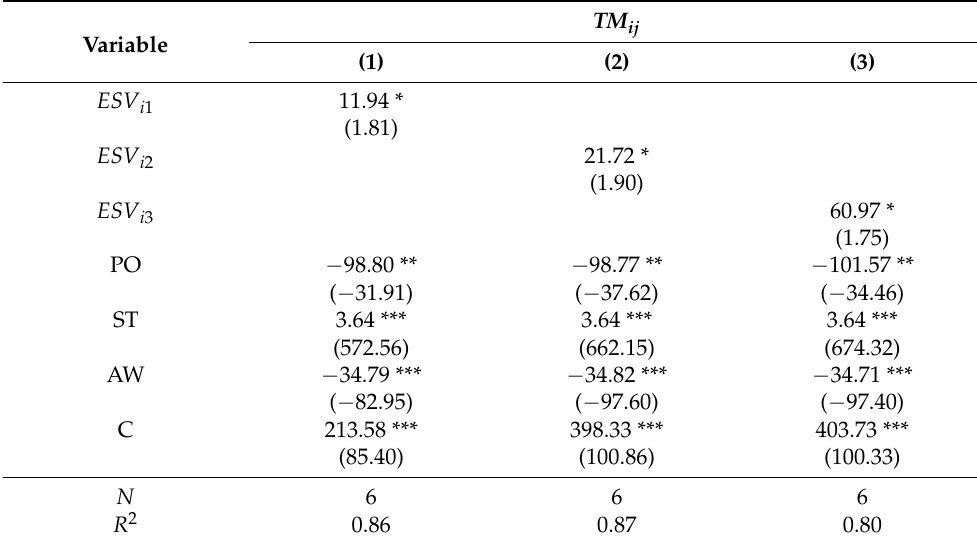
Table 6. The impact of land ecological value on the visitor